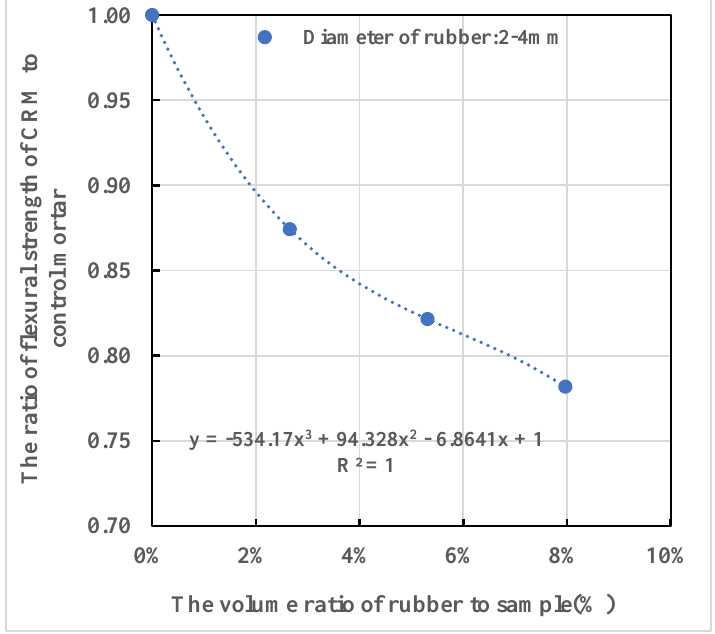
Figure 26. The best-fitting curve of flexural strength and rubber particle content.